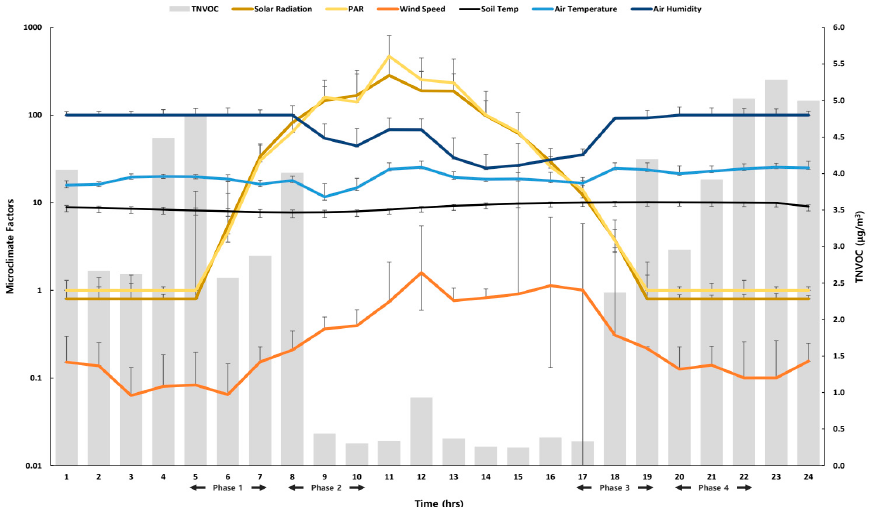
Figure 4. Diurnal graph of TNVOC (Total Natural Volatile Organic Compounds) and microclimate factors. The error bar indicates standard deviation of each indicators. The x -axis represents the time from 0:00 to 24:00 with four phases. The y -axis on the left represents the value of each microclimate factor, and the y -axis on the right represents the TNVOC value. Units of each microclimate factors: solar radiation (W/m²), PAR (uE), wind speed (m/s), soil temperature and air temperature (°C), and air humidity (% rh).